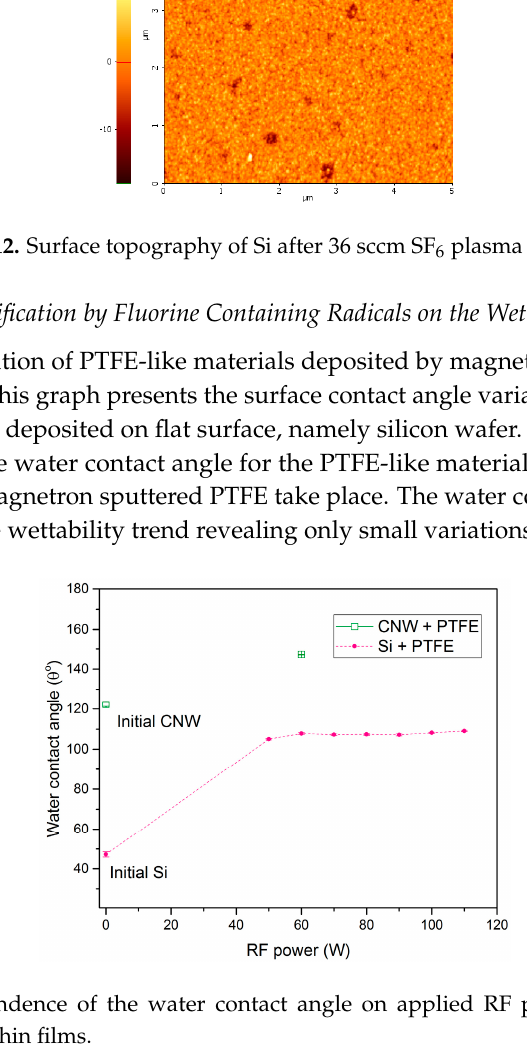
magnetron-sputtered thin films.